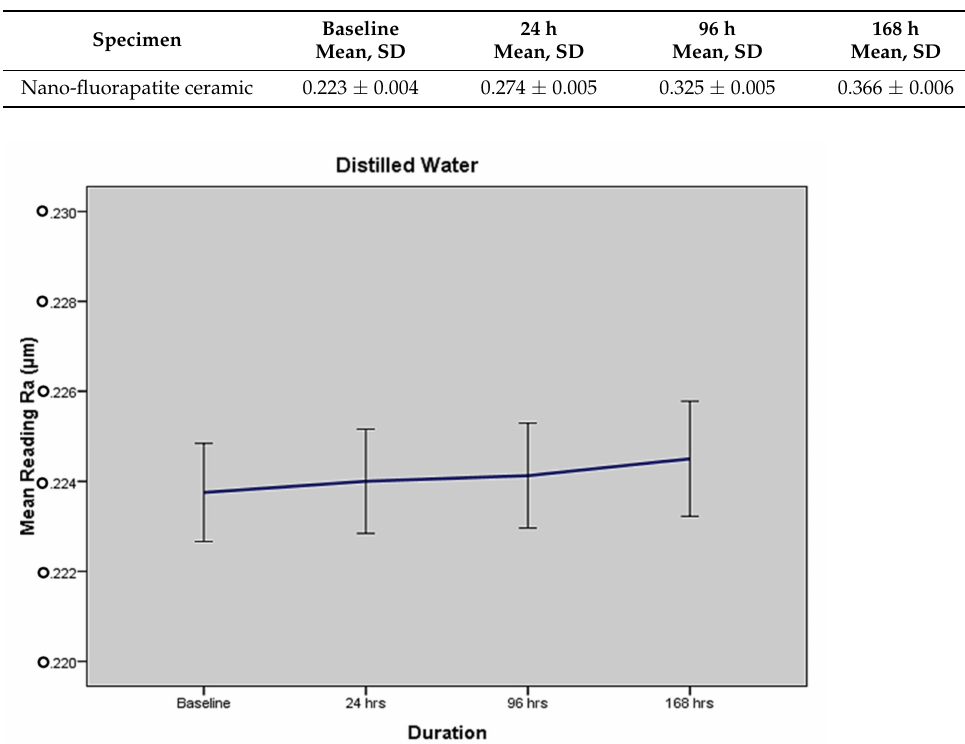
Table 2. Profilometer readings distribution for nano-fluorapatite ceramic immersed in citrate buffer at baseline and for 24 h, 96 h, and 168 h.